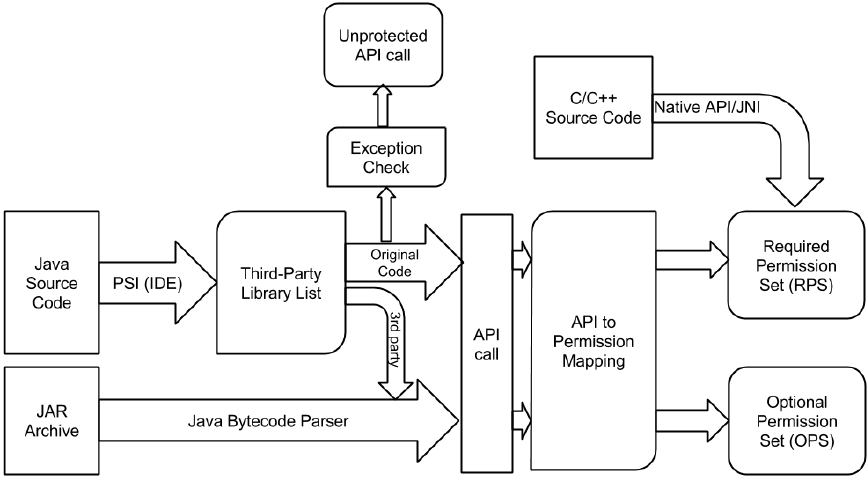
Figure 2. Overall architecture of PerHelper. PSI, Program Structure